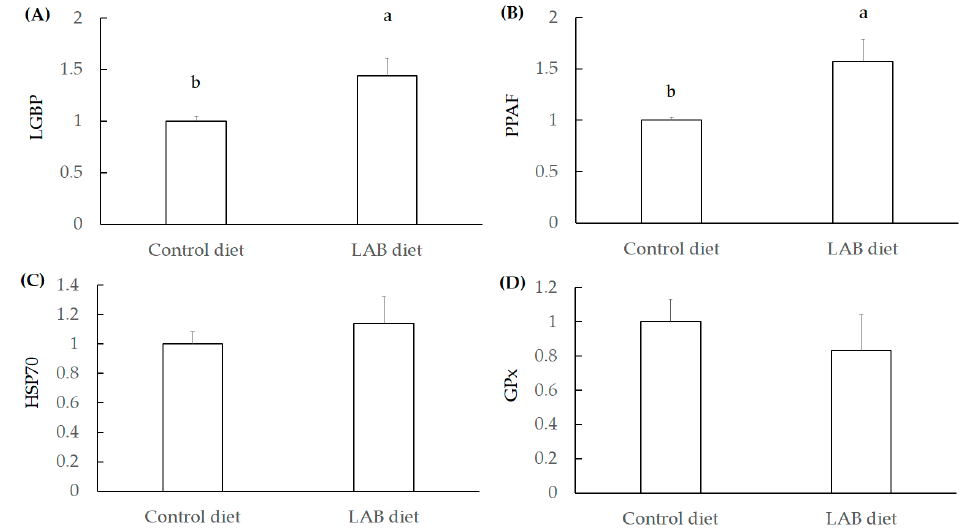
Figure 3. Expression levels of LGBP ( A ), PPAF ( B ), HSP70 ( C ), and GPx ( D ) in the hepatopancreas of L. vannamei shrimp fed with LAB feed containing L. fermentum SWP-AFFS02 as determined by RT qPCR. Significant difference is shown by different letters (a, b) ( p < 0.05) between control and LAB feed groups.